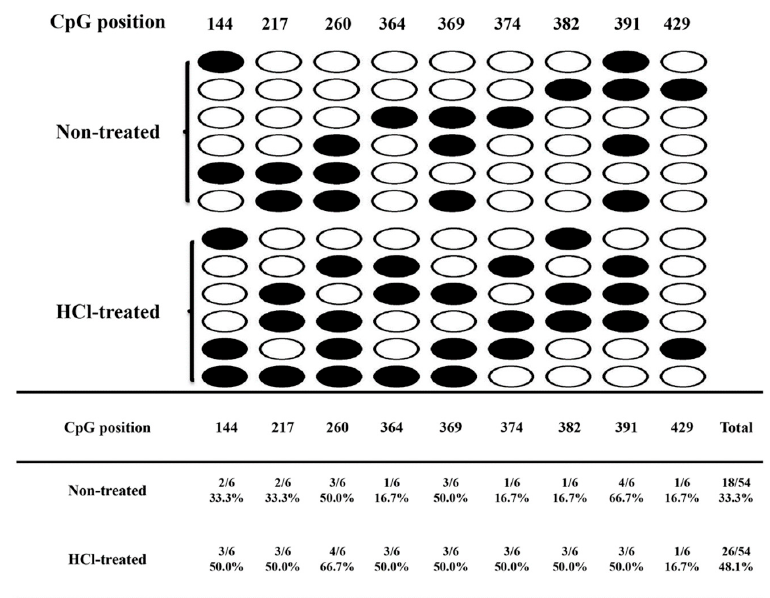
Figure 9. Bisulfite sequencing validation of the hypermethylated gene, G2E3 (101739208).The number indicates the CG position of the target gene, and the percentage represents the statistical mean methylation level of the CG site or the whole CG site. Dark circles indicate CG site methylation, and open circles refer to unmethylated cytosines. Each row consists of a single sequenced